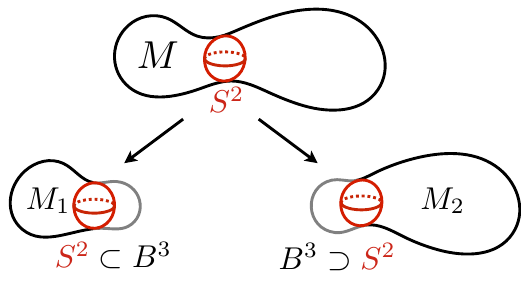
Figure 4 . Cutting 3-manifolds along S 2